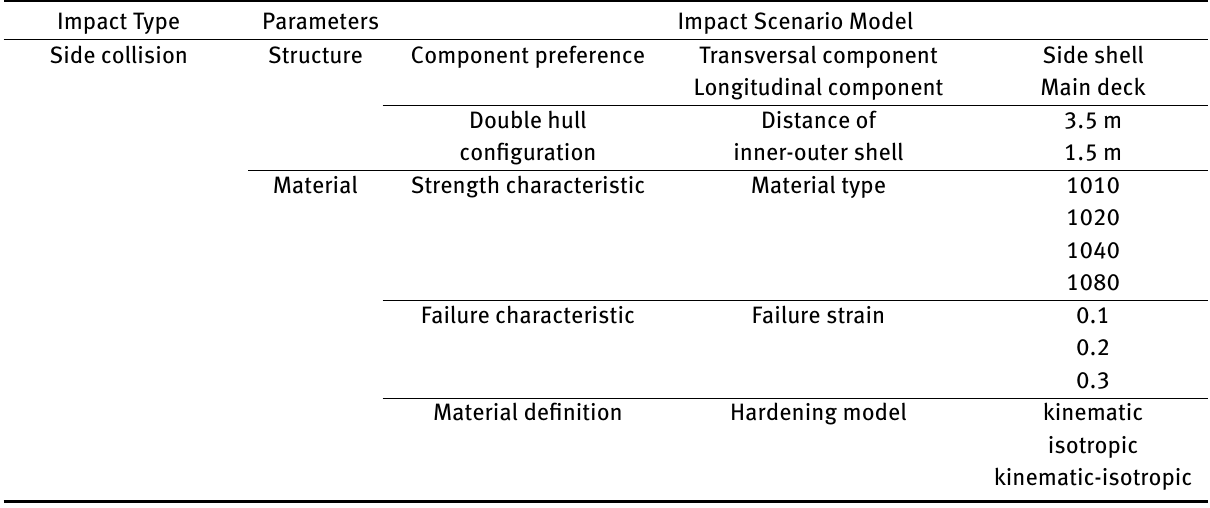
Table 2: Detail of proposed scenario